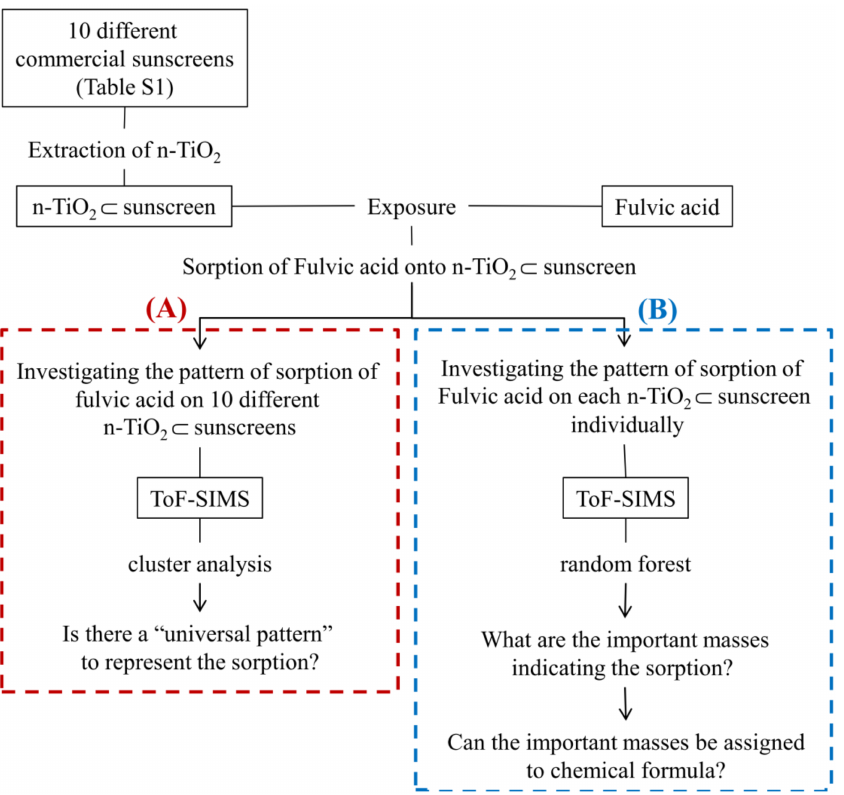
Figure 1. The sequence of study of sorption of fulvic acids onto n-TiO 2 extracted from sunscreen (n-TiO 2 ⊂